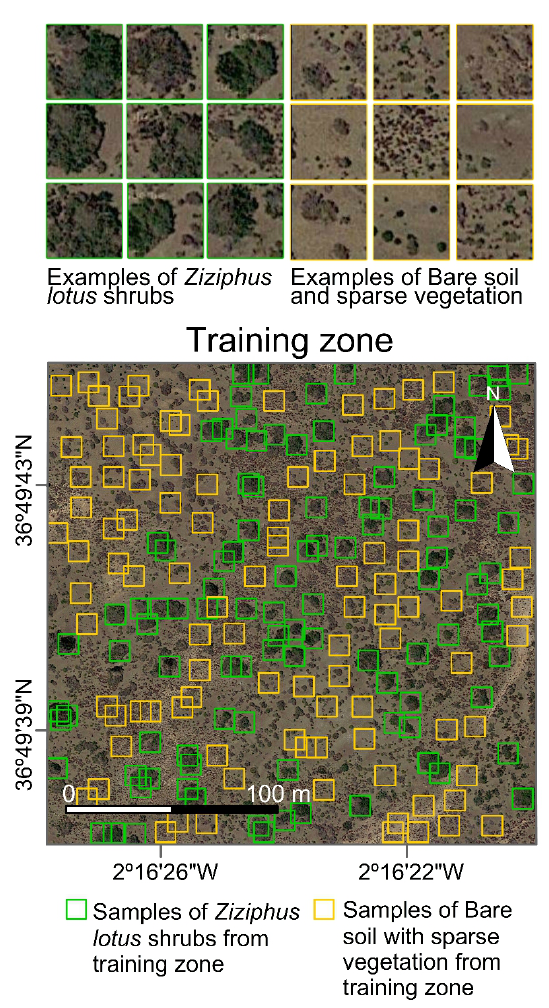
Figure 3. The two top panels show examples of the 80 × 80-pixel image patches used to build the training dataset for the CNN model: ( left ) patches of Ziziphus lotus class, ( right ) patches of Bare soil with sparse vegetation class. The bottom panel shows the training-zone dataset with 100 Ziziphus lotus patches labeled with a green contour and 100 Bare soil and sparse vegetation patches labeled with yellow